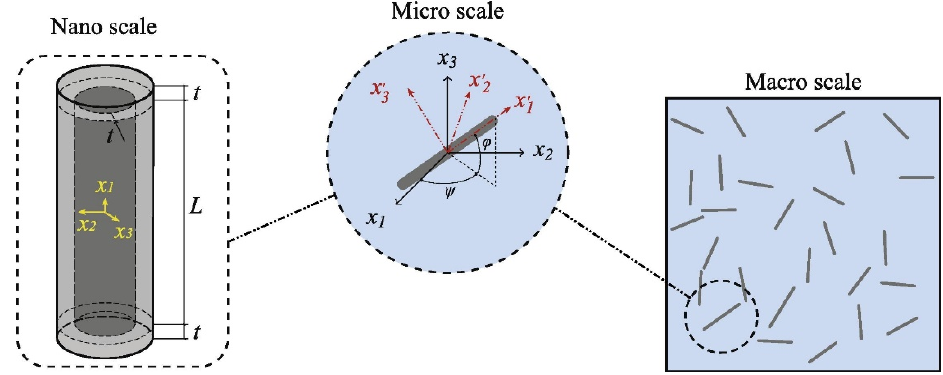
Figure 23. Representative microscale volume element (RVE) containing straight carbon fillers [79].